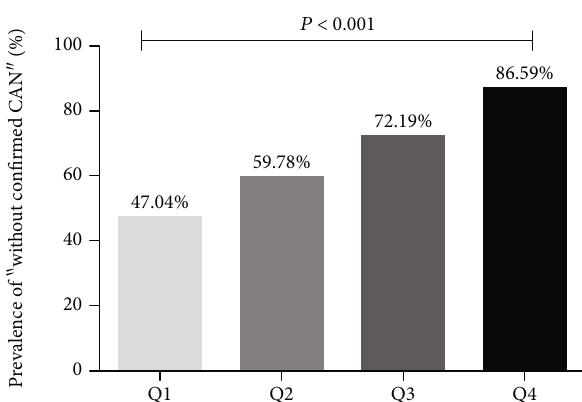
Figure 1: Prevalence of “ without con fi rmed CAN ” in di ff erent quartiles (Q1-Q4) of TIR. a CAN: cardiovascular autonomic neuropathy. b TIR Q1 ≤ 41 %, Q2: 41-64%, Q3: 64-83%, Q4 > 83 %. c As shown in this fi gure, patients were divided into groups according to quartiles of the time in range (TIR), the proportion of “ without con fi rmed CAN ” increased with the increase of TIR, ( P < 0 : 001 ). P value for the signi fi cant di ff erence among the groups was determined by χ 2 -test.